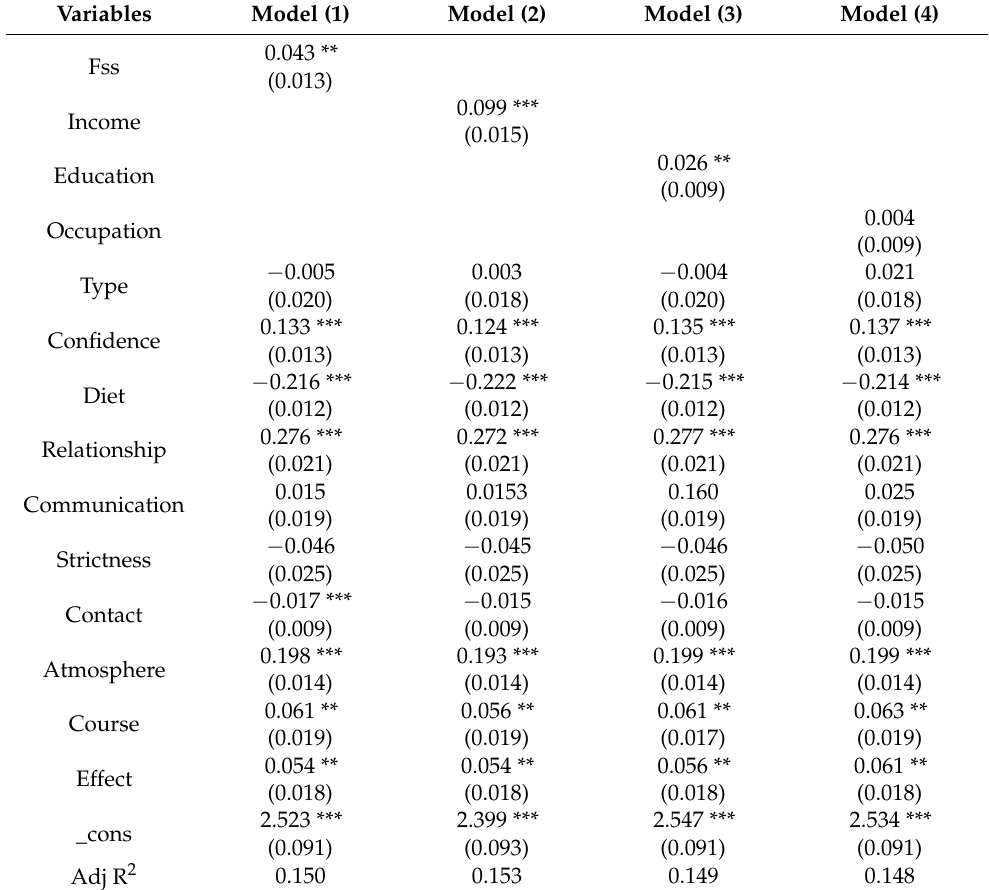
Table 3. OLS regression results of mental health of